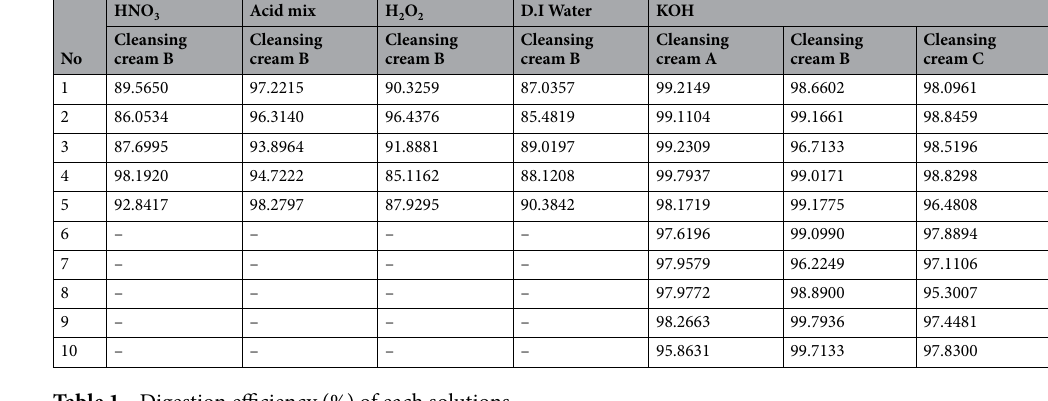
Table 1. Digestion efficiency (%) of each solutions.